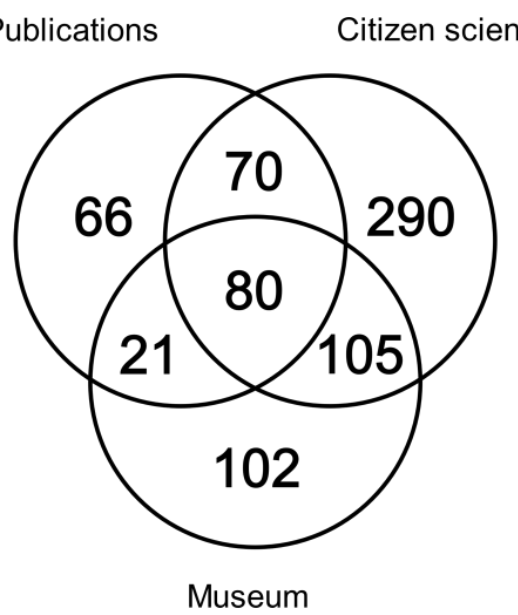
Figure 1. Contribution of unique and shared 10 × 10 km Universal Transverse Mercator (UTM) grid cells by each data source to the distribution map of the European stag beetle in Spain.